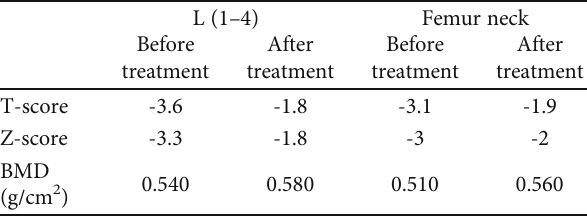
Table 2: BMD before and 18 months after treatment. L (1 – 4) Femur